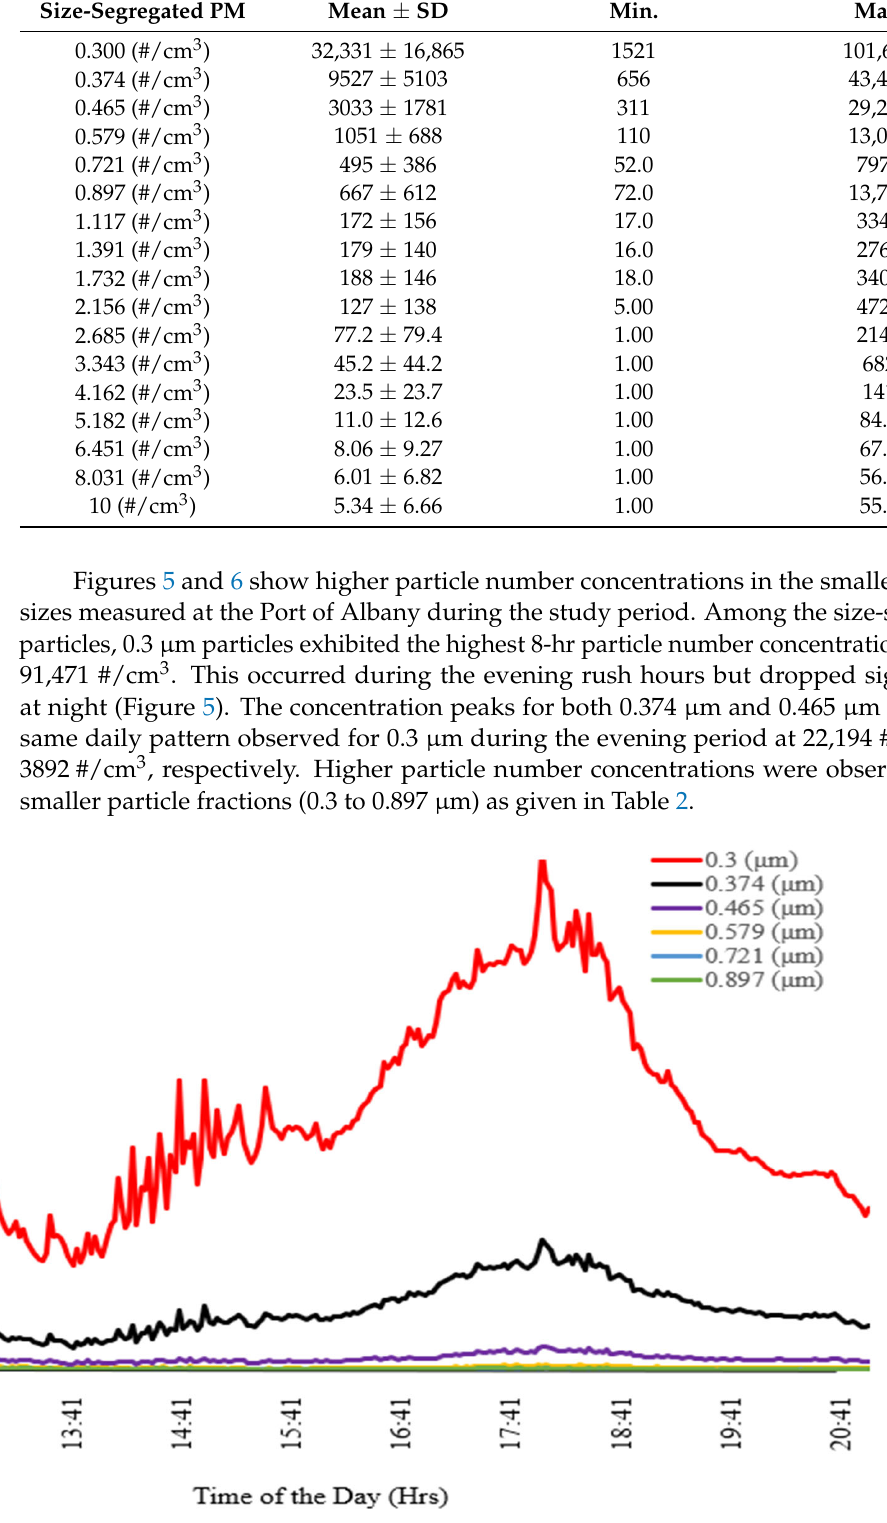
Figure 6. Size segregated sub ‐ micron PM particle number variations at the Port of Albany on 15 November 2018. Figure 6 shows a similar concentration peak in the evening with an additional peak in the afternoon at a maximum of 50,546 #/cm 3 for 0.3 μ m. Particle sizes of 0.374 μ m and 0.465 μ m followed the same pattern of temporal variation with maximum concentrations of 20,889 #/cm 3 and 8147 #/cm 3 , respectively. In contrast to Figure 5, the maximum